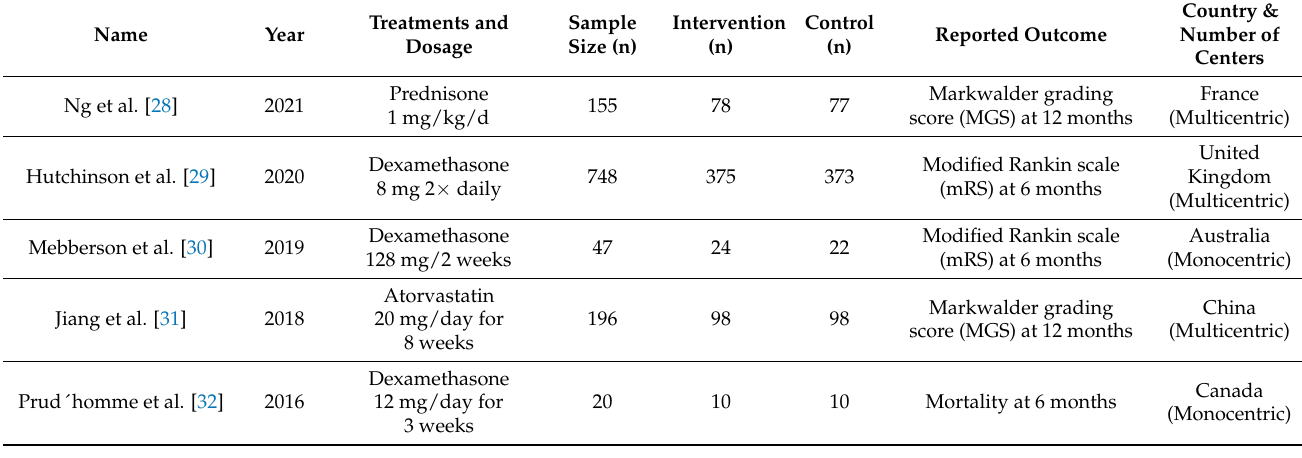
Table 1. Major characteristics of anti-inflammatory studies included in the present meta-analysis.